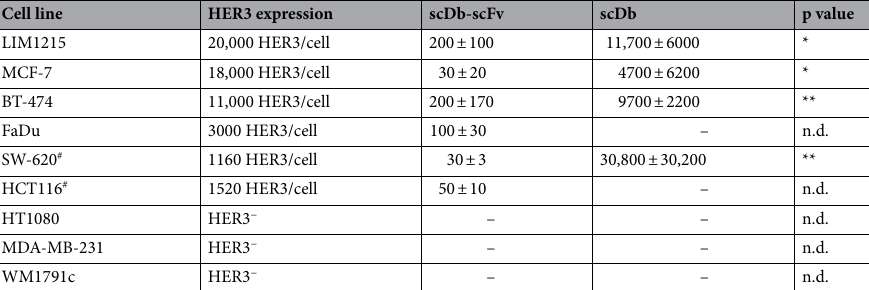
2 (EpAh2), a trend in which the potency of bscEphA2xCD3 increased as the number of EphA2 binding sites on the tumor cells increased was observed 39 . Similarly, a bispecific antibody against HER2 and CD3 showed high potency towards cells with amplified or overexpressed HER2 (~ 2 × 10 6 molecules/cell) and ~ 40-fold reduced potency for cells with lower target expression (~ 15,000 molecules/cell) 40 . In line with this, scDb-scFv showed an approximately 100-fold reduced T-cell mediated killing of low HER3-expressing tumor cells (FaDu: ~ 3000 HER3/cell) compared to intermediate HER3-expressing tumor cells (MCF-7: ~ 18,000 HER3/cell).